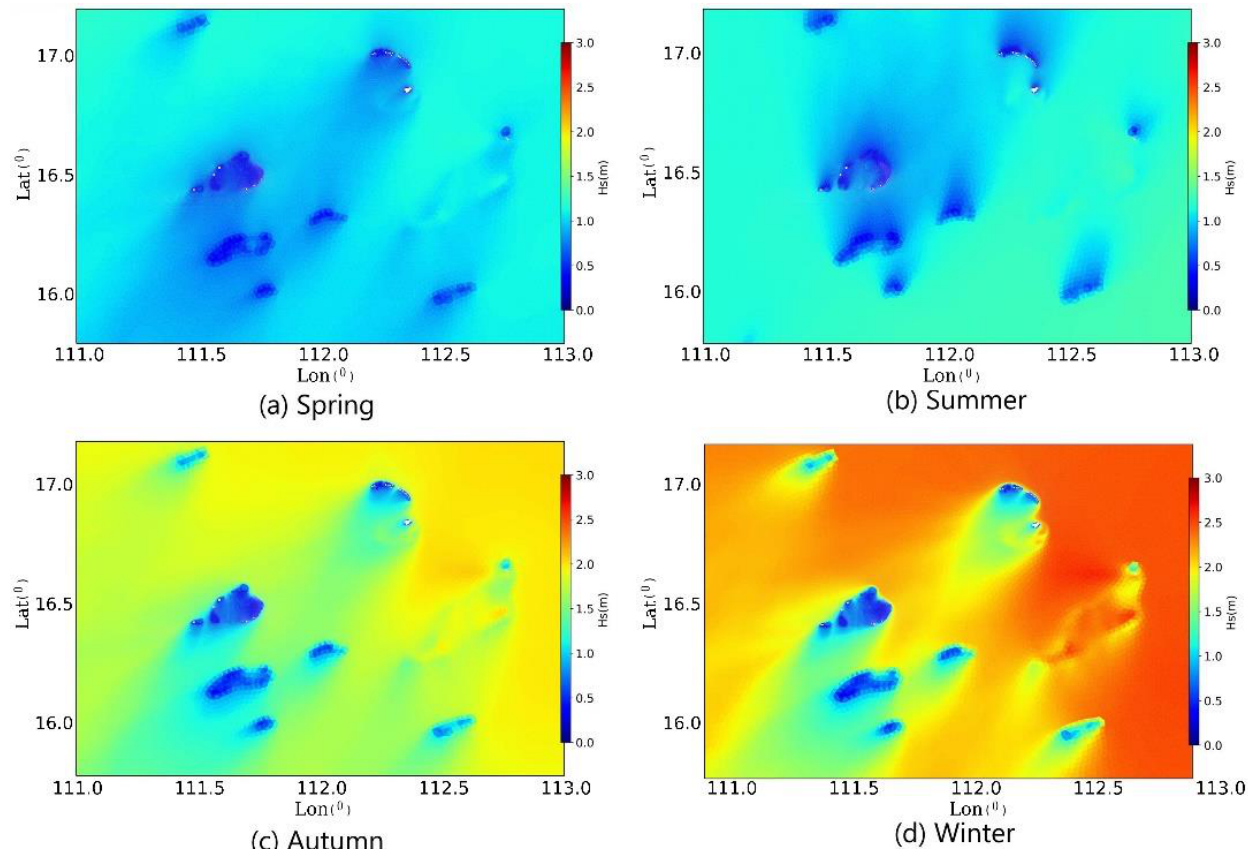
Figure 9. Distribution of seasonal mean Hs in the Xisha Islands.